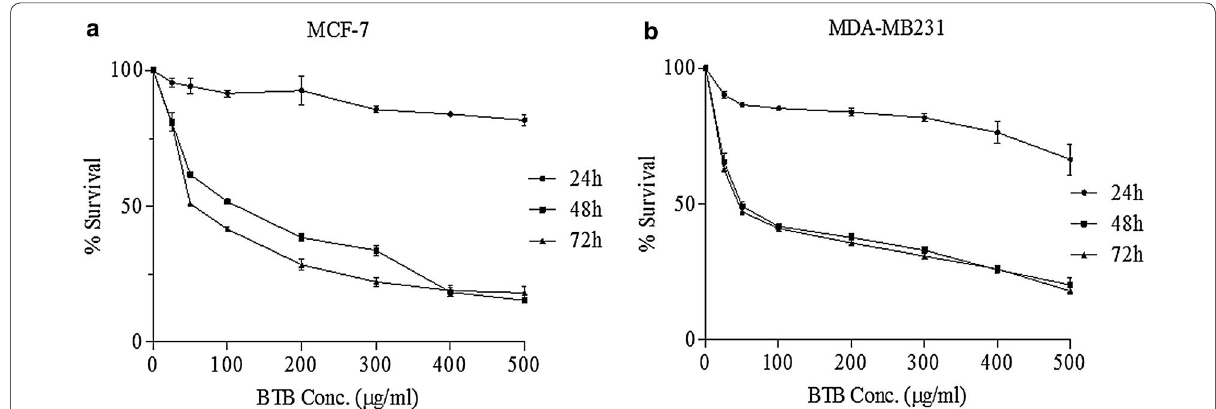
Fig. 1 Dose-response curve showing % viability of MCF-7 ( a ) and MDA-MB231( b ) cells at 0–500 µg/ml concentrations of BTB extract for three dif- ferent time points (24, 48 and 72 h). IC 50 was found to be 50 μg/ml in MDA-MB231 after 48 h while in the case of MCF-7 cells it was 50 μg/ml after 72